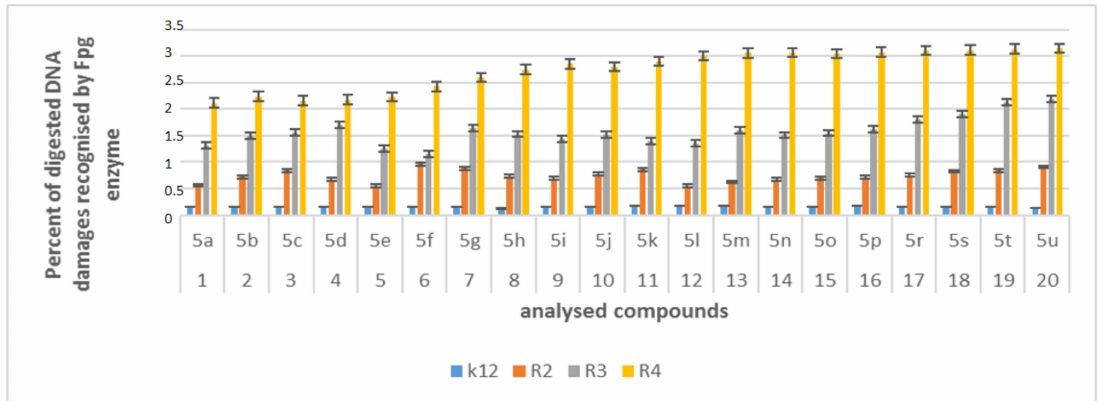
Figure 7. Percent of digested DNA damages recognised by Fpg enzyme- (y-axis) with control K12 and R2-R4 strains (x-axis); The compounds 5a , 5b , 5e , 5g , 5j , 5k , 5p, and 5o were statistically significant at < 0.05